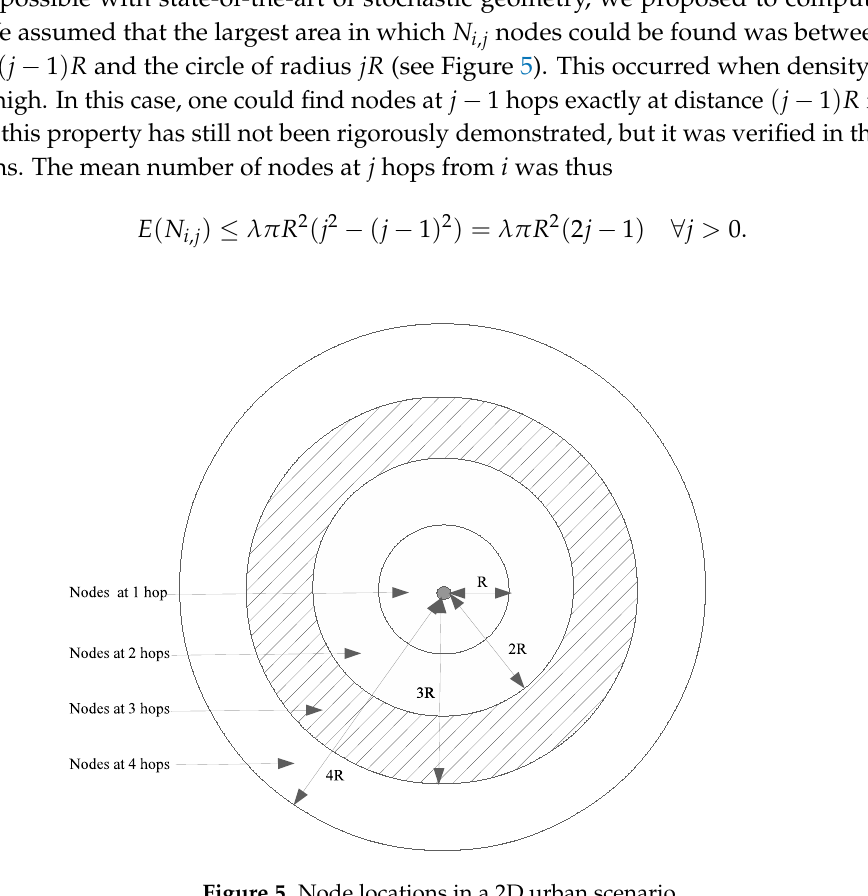
Figure 5. Node locations in a 2D urban